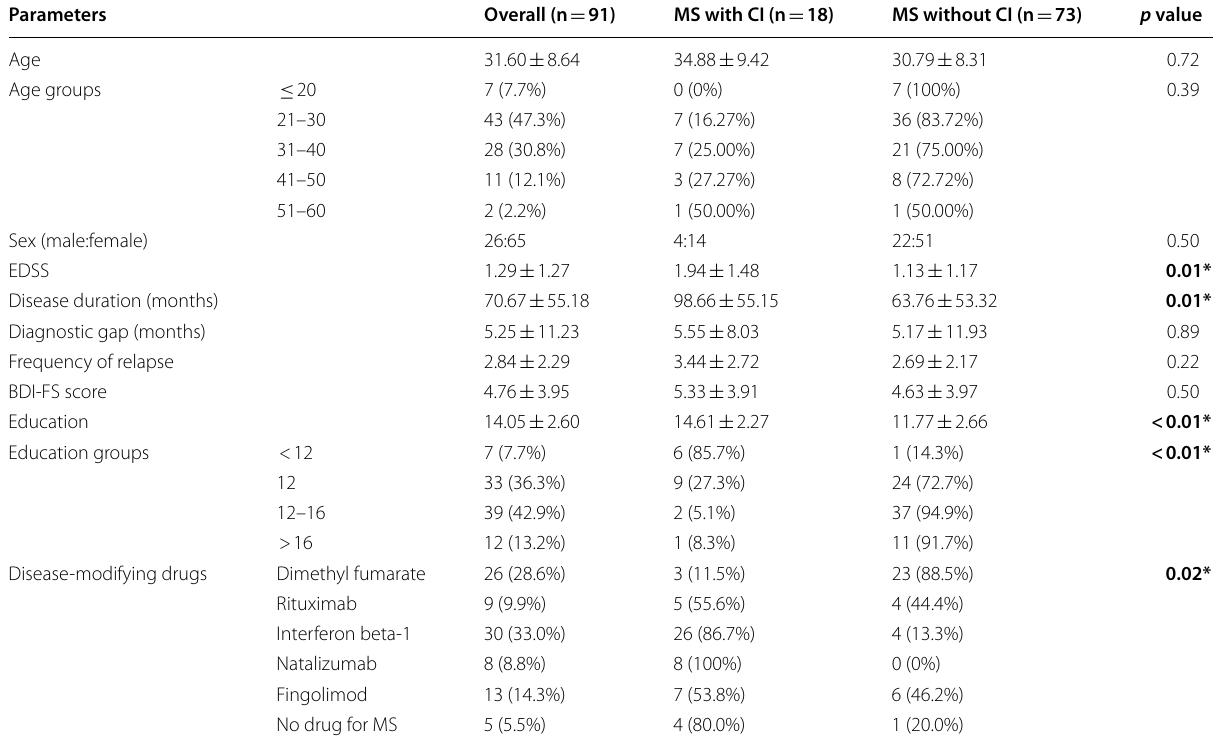
Table 1 Demographic and clinical characteristics of the participants